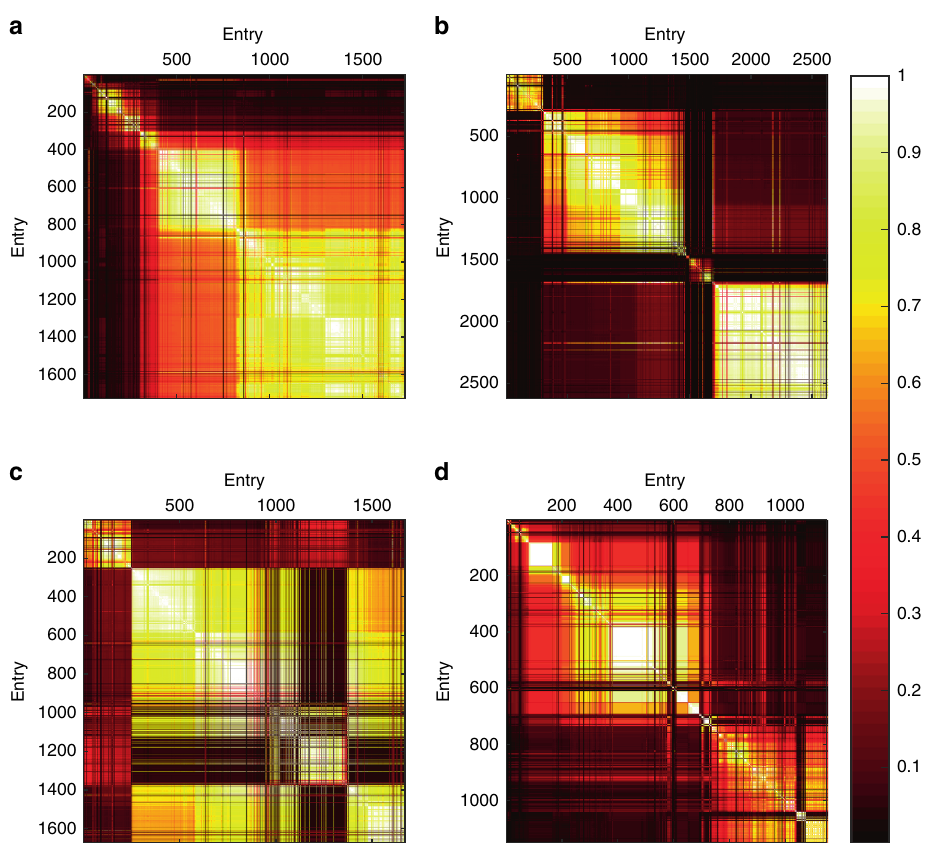
Fig. 3 Code similarity matrices between all pairs of entries in four sample contests. Entries are ordered chronologically on time of entry from top to bottom and left to right. Each point represents the similarity between two entries. The bright squares show series of entries similar to each other compared to previous and subsequent periods, representing minor variations on a solution ‘ theme ’ . The bottom-right corners of the bright squares show where the population switched to a new form of solution that was relatively dissimilar to those before, and the top-left corners show where a new solution ‘ theme ’ began. Data are shown for four contests: a Gerrymandering — April 2004 ( n = 1726), b Peg Solitaire — May 2007 ( n = 2620), c Colour Bridge — November 2009 ( n = 1671) and d Mars Surveyor — June 1999 ( n = 1148; for ease of visualisation, here we only plot the entries for which the participants reported copying — see Supplementary Methods). Tweaks are manifest as lighter colours, and leaps as darker regions. a The fi nal large cluster of solutions shows intermediate similarity to a previous smaller group. b The three distinct groups of similar solutions show the population switching to completely new ideas. c The population reverts to a previous idea, generating high similarity between the fi nal and second group. d A contest characterised by rapid shifts in